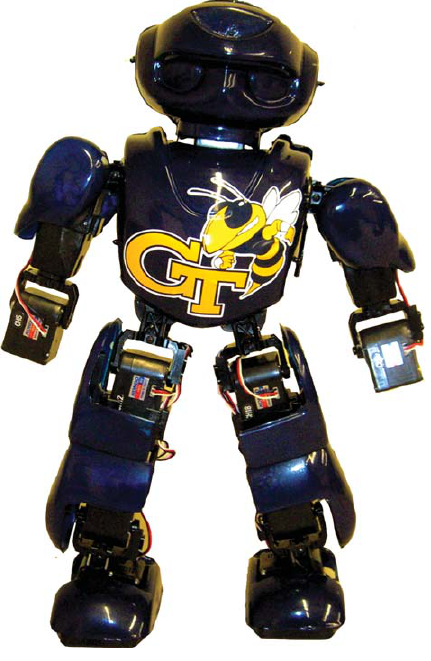
Fig. 13. Illustration of the robotic